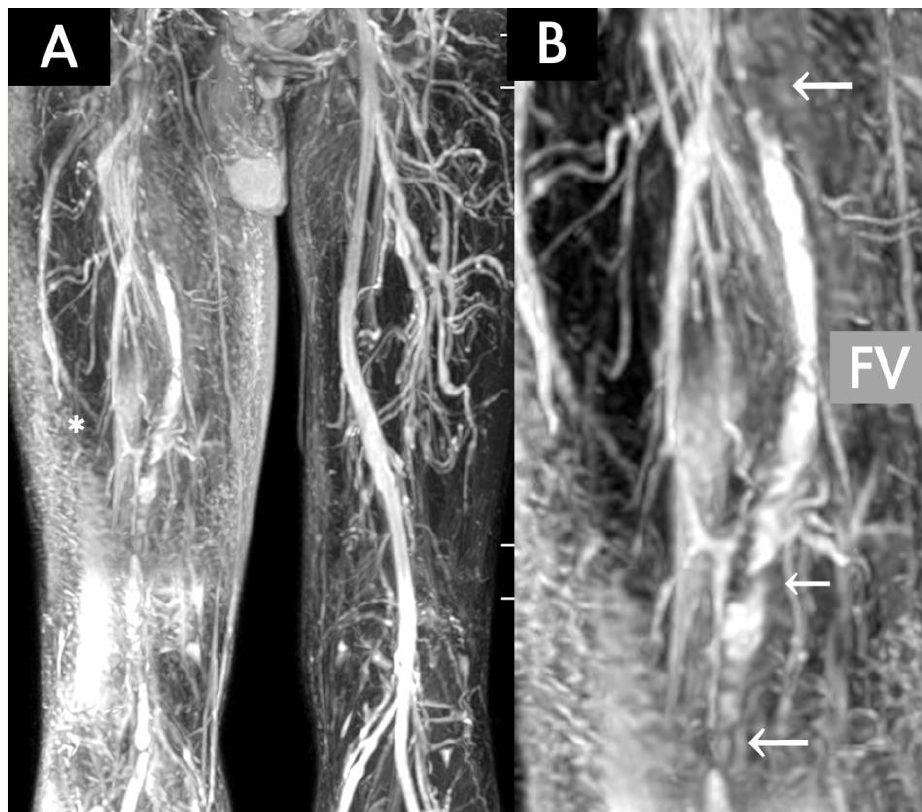
Figure 2. A 51-year-old man with acute deep vein thrombosis of the right lower limb who received an EkoSonic endovascular system (EKOS) thrombolytic therapy to the counter-lateral limb 3 days ago. ( A ) TRANCE-MRI revealing diseased venous systems and extensive soft tissue (white asteroid) enhancement in the morbid right thigh and normal veins in the left thigh. ( B ) Multiple residual venous thrombi (white arrows) in the right femoral vein (FV).